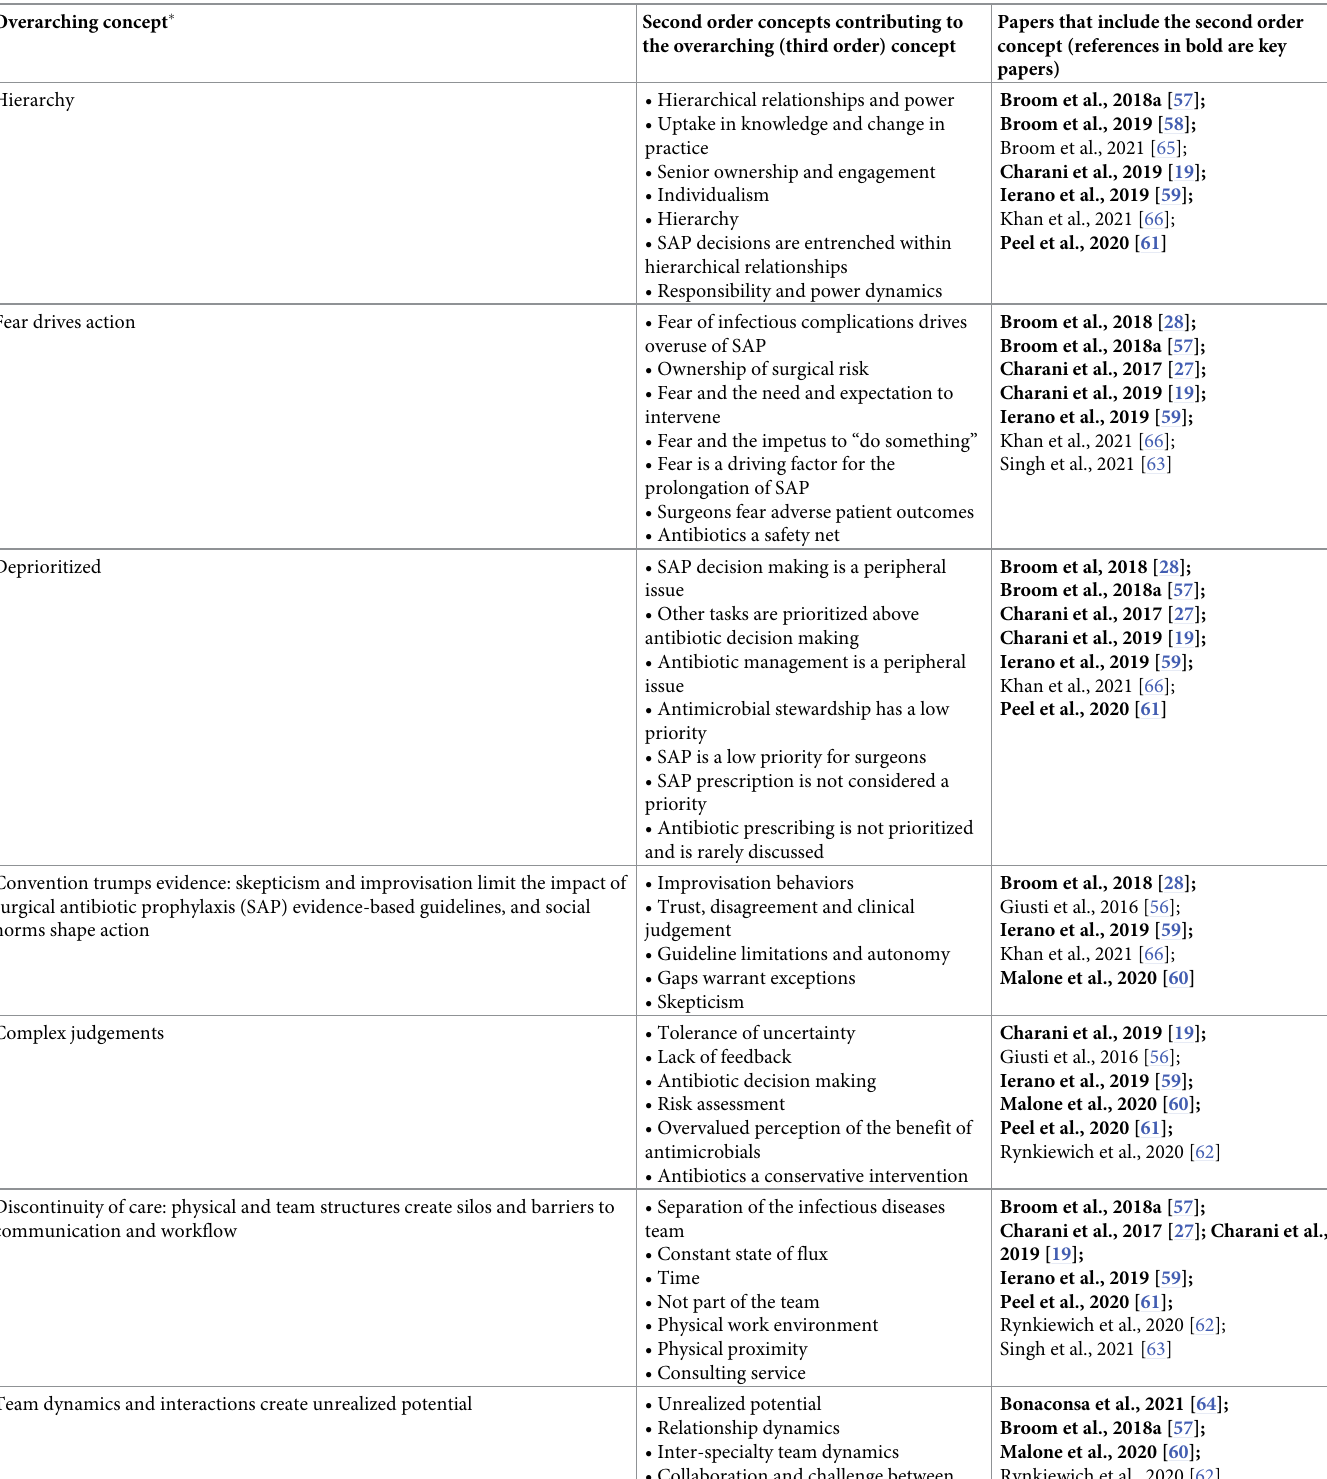
Table 4. Translation of second order concepts, from the 14 included papers, into overarching (third order)